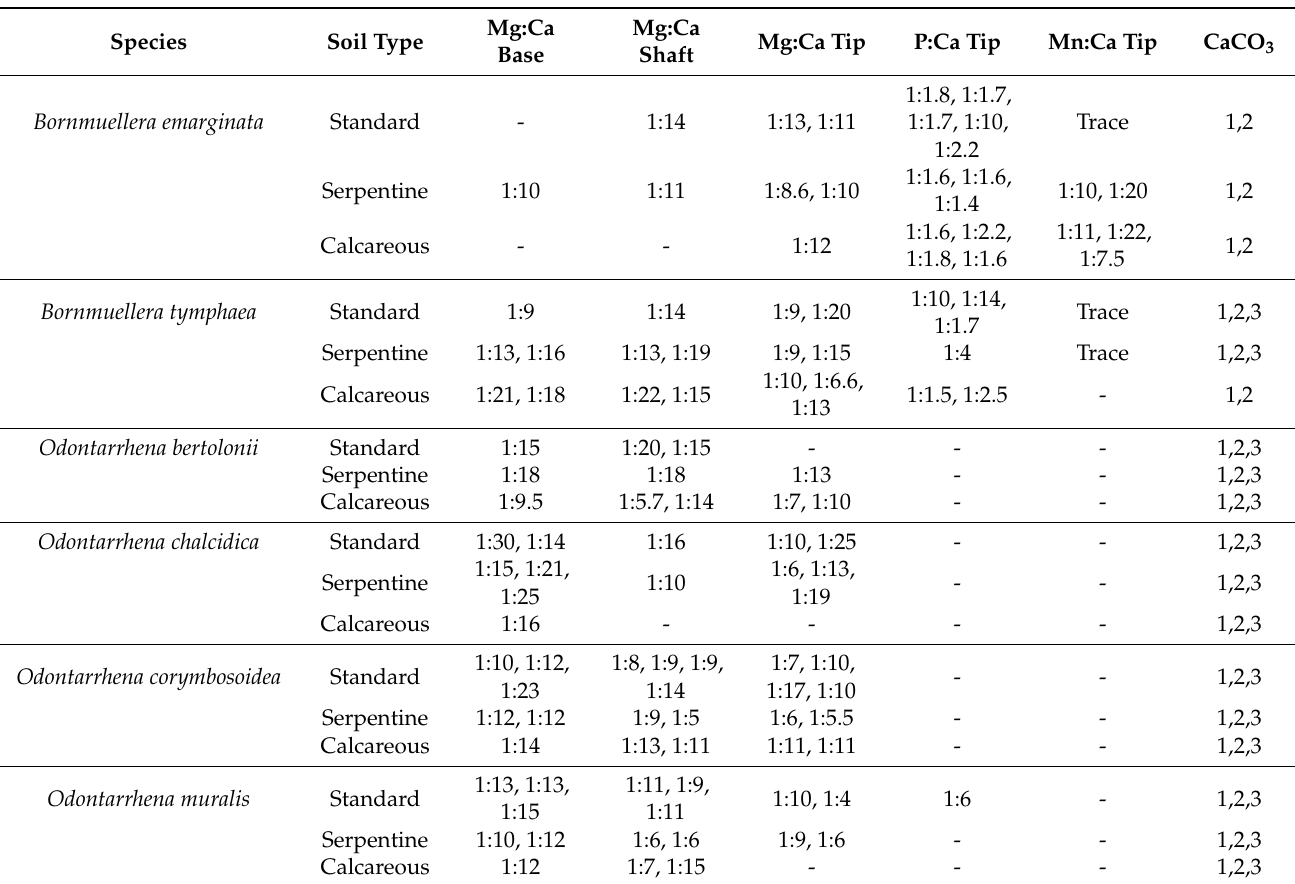
Table 4. Elemental distribution of analyzed spots across the soil types of the species cultivated in Bonn. The presence of Mg, P, and Mn is expressed as a ratio. CaCO 3 is expressed as present or absent.